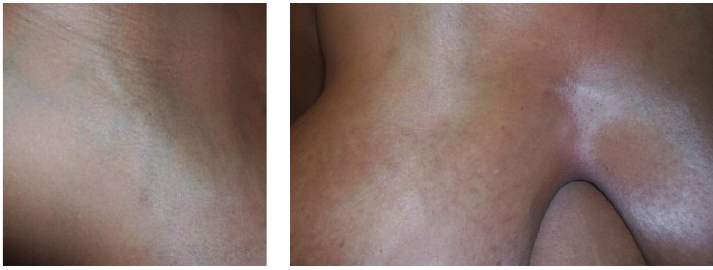
Figure 2: Dilated veins on the upper thorax in a patient presenting at 37 weeks with gestational gigantomastia.